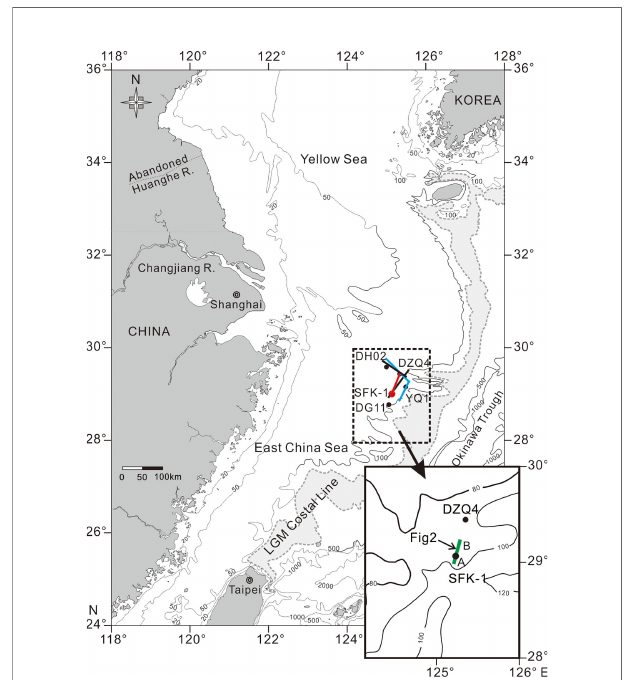
FIGURE 1 | A sketch map of the East China Sea (ECS) with the locations of core SKF-1 and other boreholes, and seismic mentioned in this study. The index map shows the seismic track line A-B across the studied core (see Figure 2 for the details). The black, blue and red solid lines are seismic track lines in Liu et al. (2000)/Berne ́ et al. (2002), Xu et al. (2020), and this study, respectively. The green solid line is the selected part of the pro fi le cross SFK- 1 and DZQ4. The coastal line (gray shaded area) at the last glacial maximum (LGM) is modi fi ed after Saito et al.